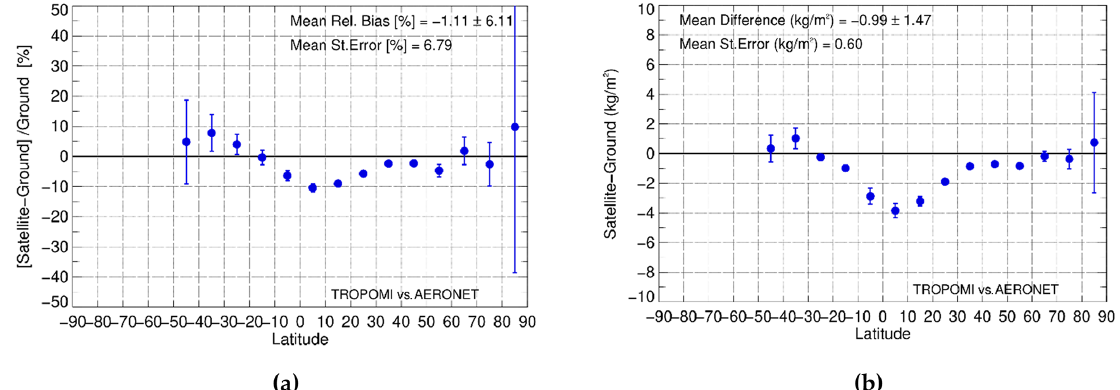
Figure 9. (a) The relative percentage differences between co-located TROPOMI/S5P TCWV measurements and ground-based observa- tions from AERONET instruments plotted versus latitude. (b) As in panel (a) but for the differences between satellite- and ground-based observations (in kgm − 2 ). In both panels, the error bars show the standard error of the mean with a confidence interval (CI) of